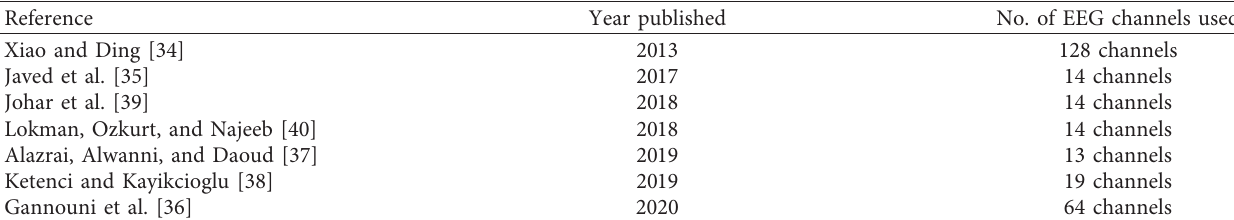
Figure 2: The international 10–20 electrode placement protocol: (a) side view; (b) plan view Table 2: Number of EEG channels used in related studies.